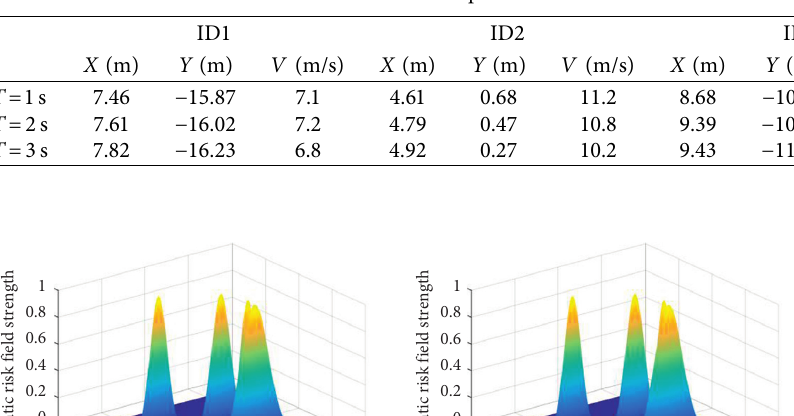
Table 3: The state prediction effect of the Attention-BiLSTM model.